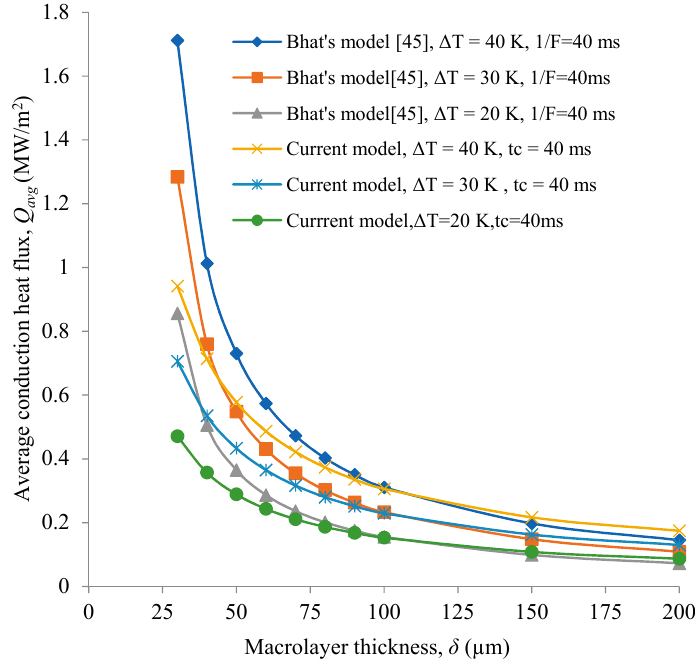
Figure 5. Dependence of average conduction heat fluxes on macrolayer thickness ( t c = 40 ms, 1/F = 40 ms).